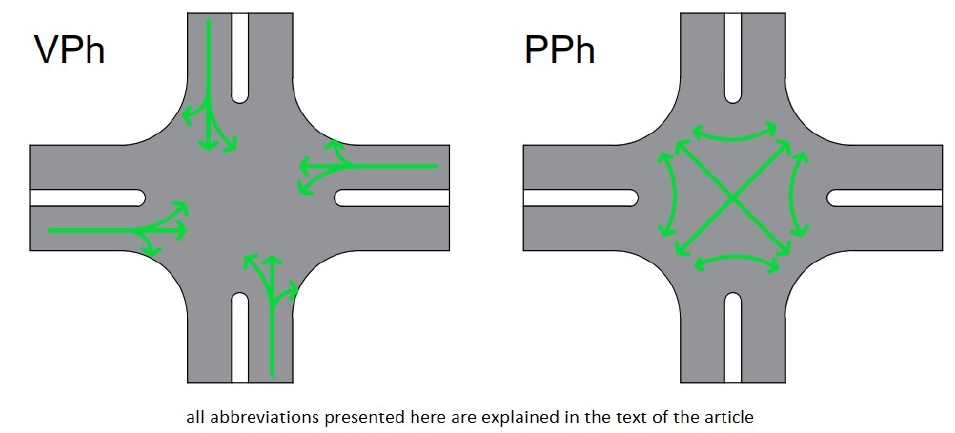
Figure 4. Concept of two-phase signaling.